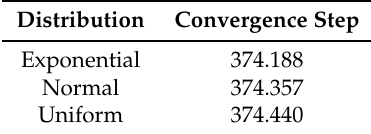
Table 1. Average convergence step under different distributions.